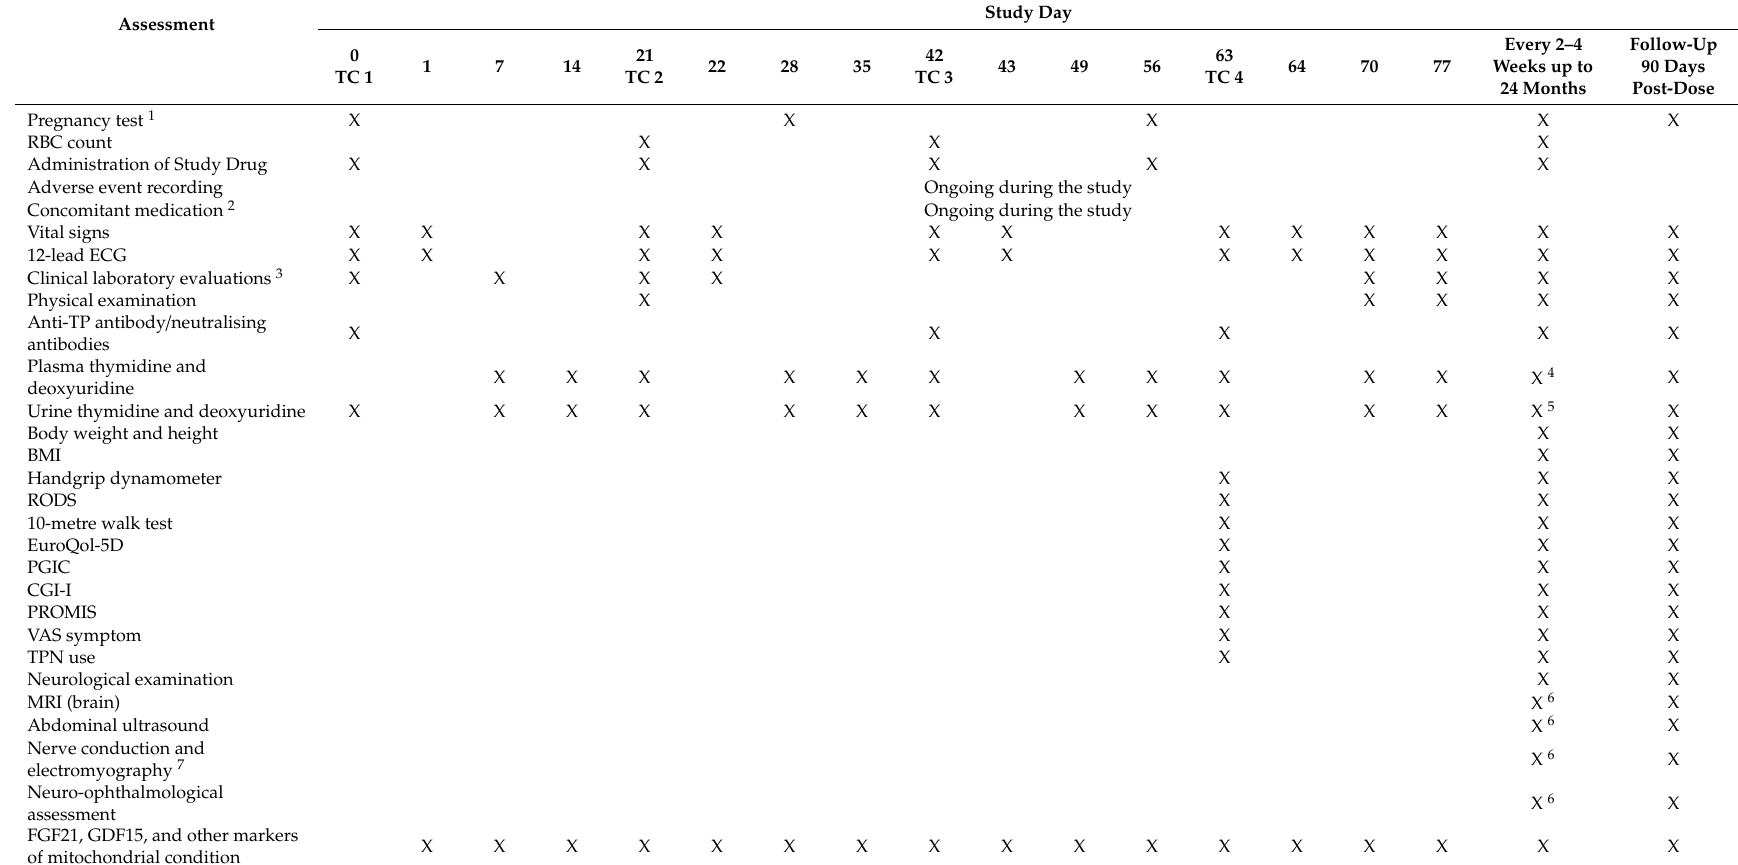
Table 4. Schedule of assessments during the treatment and follow-up